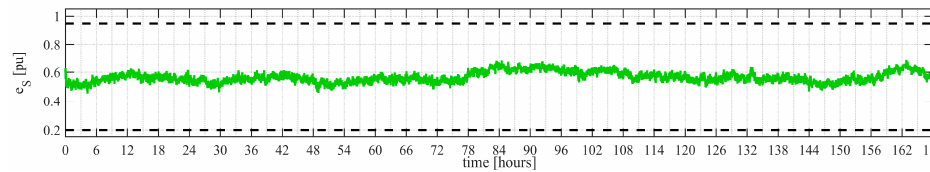
Figure 22. The S power profiles achieved by FBM over a generic week at T = 24 h.